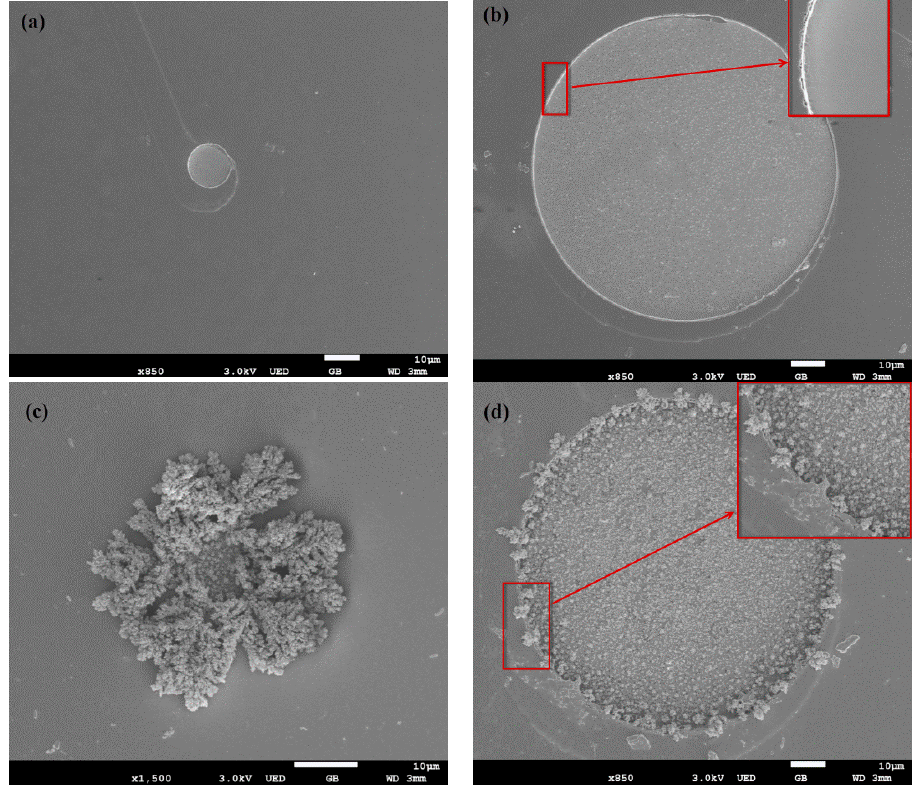
Figure 6. SEM images of stimulating sites ( b , d ) and recording sites ( a , c ) before ( a , b ) and after ( c , d ) electrodeposition of AuNPs.